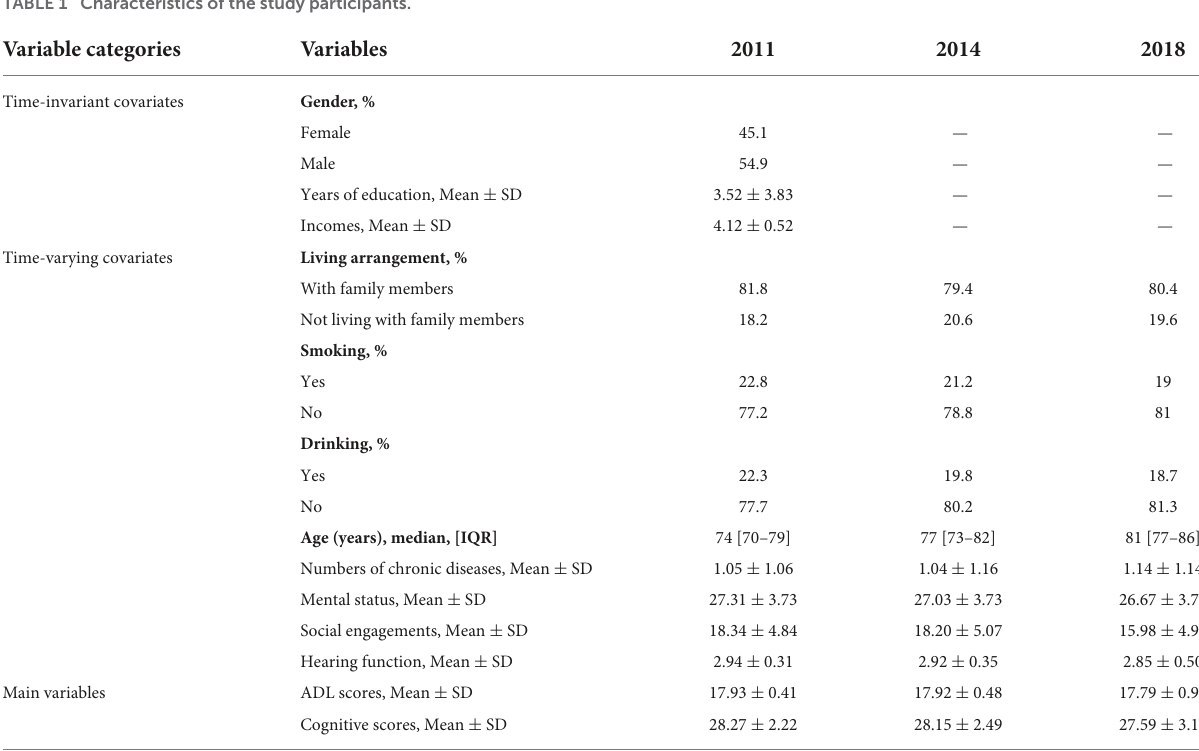
TABLE 1 Characteristics of the study